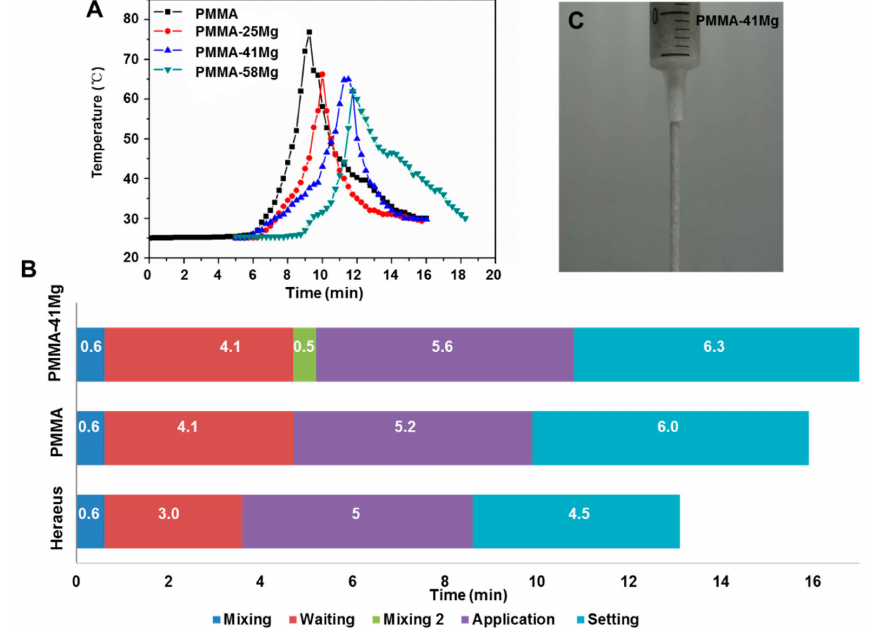
Figure 6. ( A ) Heat evolution curves for the setting reactions of bone cement; ( B ) solidification characteristics of PMMA–41Mg measured at 25 ◦ C, with PMMA bone cement and Heraeus cement as control; ( C ) the injectability of PMMA–41Mg bone cement.